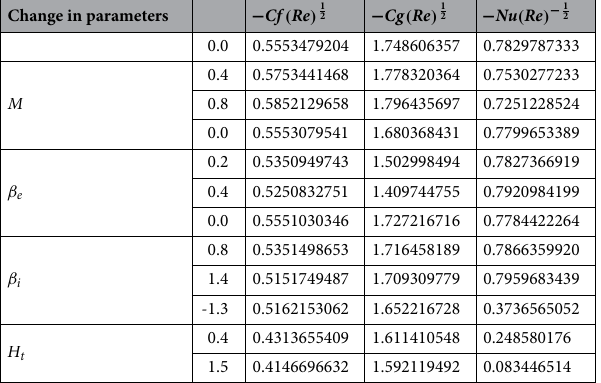
Table 4. Numerical effects of flow rates and Nusselt number versus β e , M , β i and H t .